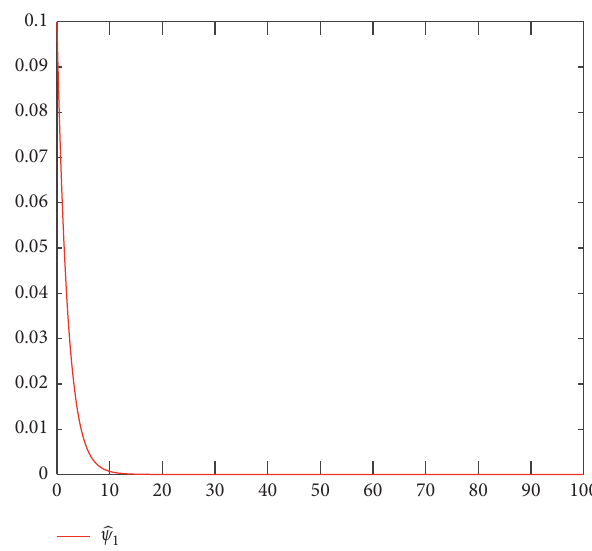
Figure 4: The response of the adaptive rate 􏽢 ψ